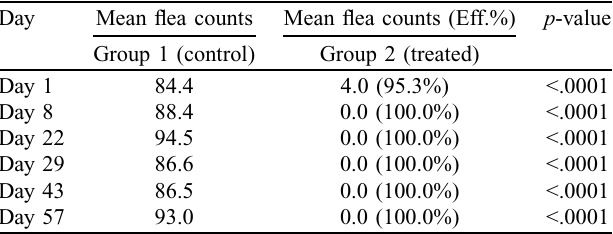
Table 3. Flea counts on dogs and 36h efficacy based arithmetic